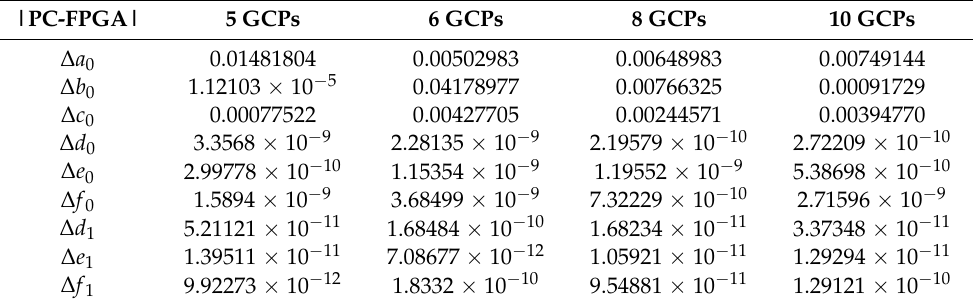
Table 5. Differences of calibration between FPGA-based and PC-based calculations.